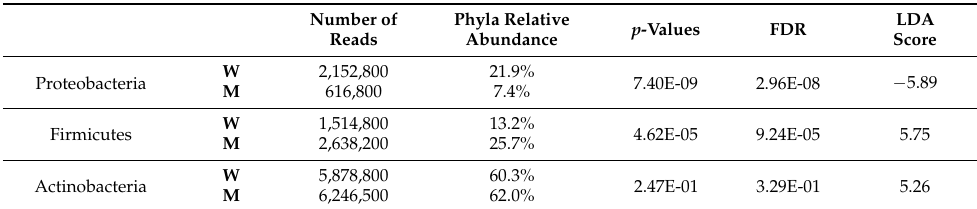
Table 3. Results of taxa abundance and LefSe analyses.